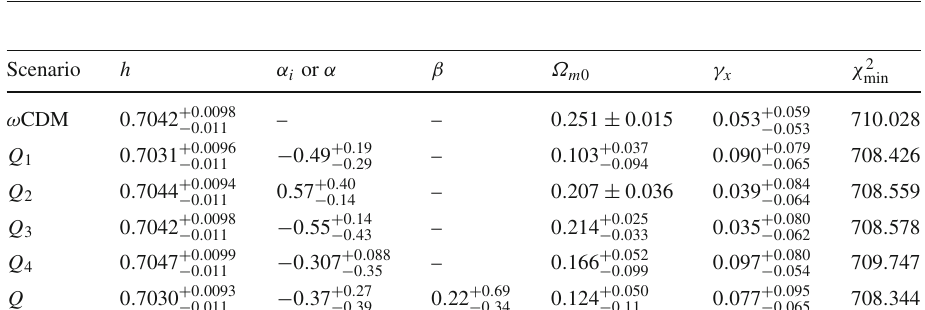
Table 5 Best fit parameters and 1 σ error for the analysis using JLA + H 0 + H ( z ) . As